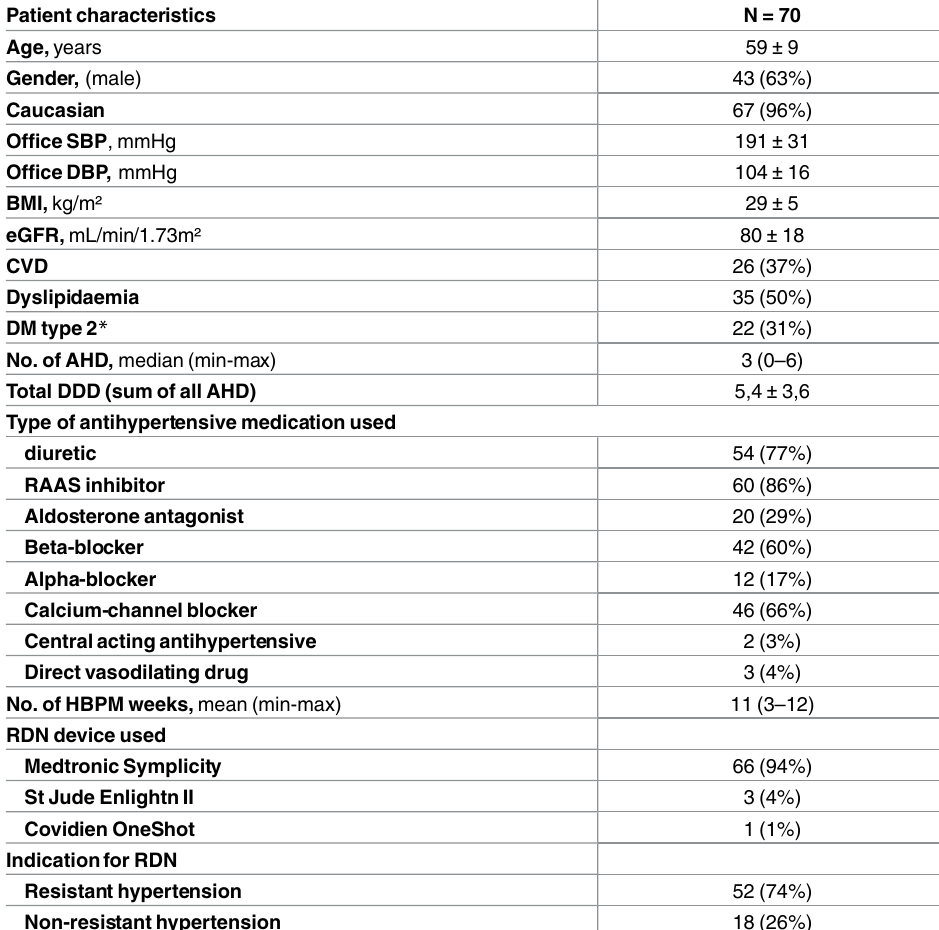
Table 1. Patient characteristics.